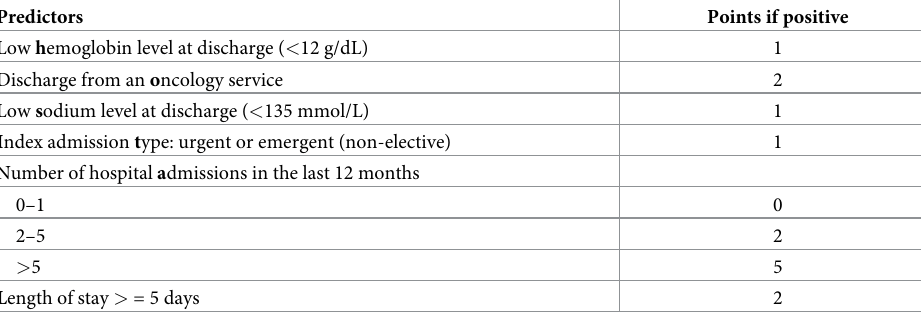
Table 1. The Simplified HOSPITAL score